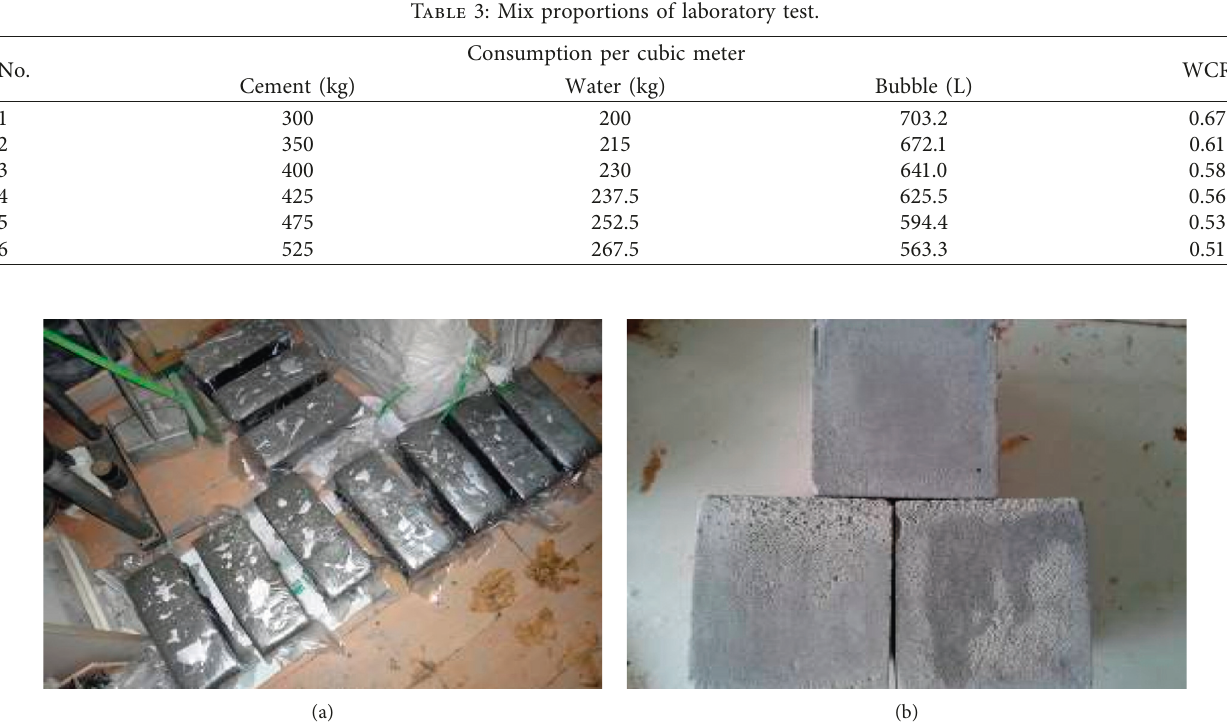
Figure 2: FMLS samples: (a) paste in curing; (b) form